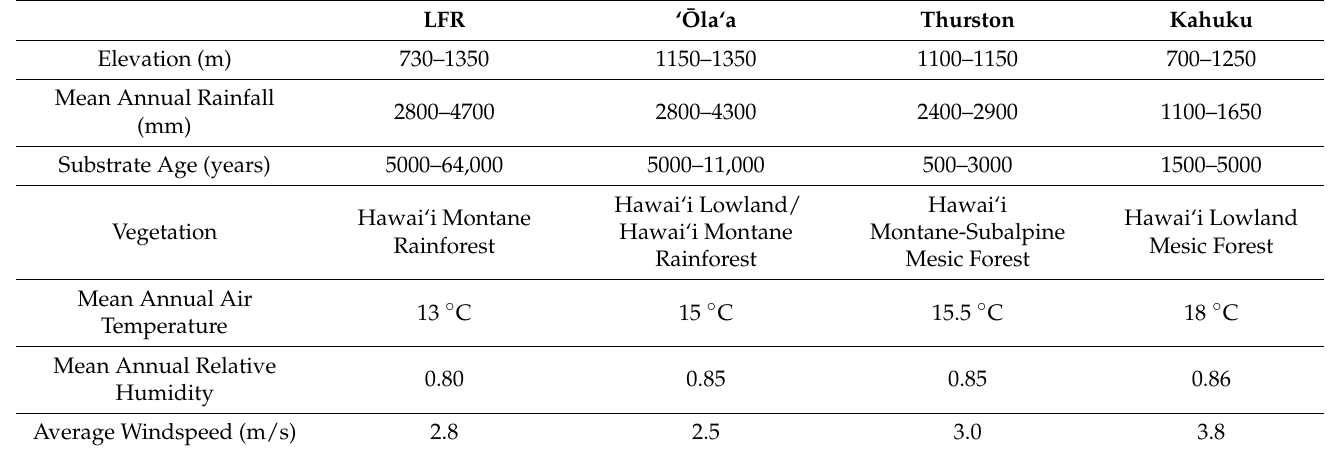
Table 1. Environmental parameters of the four study sites